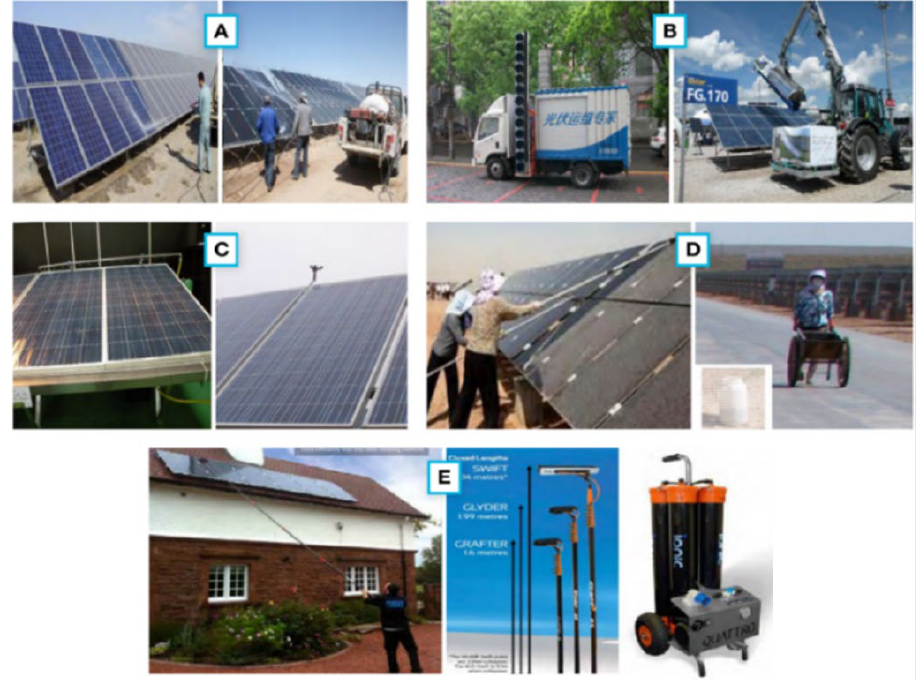
Figure 9. Popular PV panel cleaning methods in the desert. ( A ) Spraying water; ( B ) special cleaning vehicle; ( C ) water pipes; ( D ) human method; ( E ) special pressured water brush.